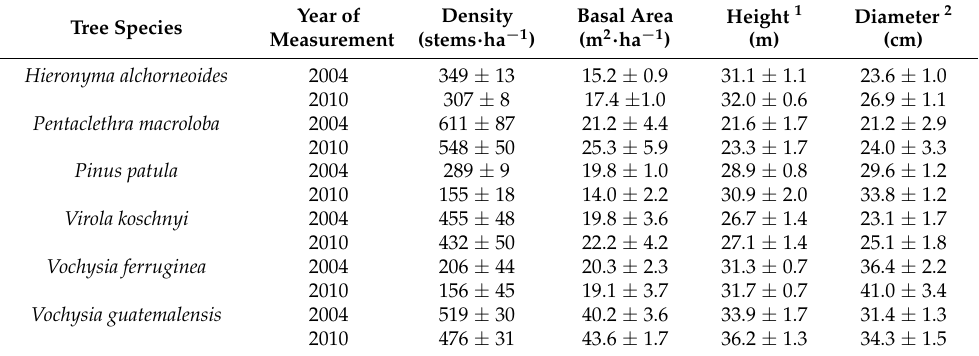
Table 1. Characteristics of the experimental tree plantations in 2004, fifteen years after planting, and in 2010, at the end of this study. Values are means ± 1 S.E. based on measurements of all trees in four replicates of each plantation